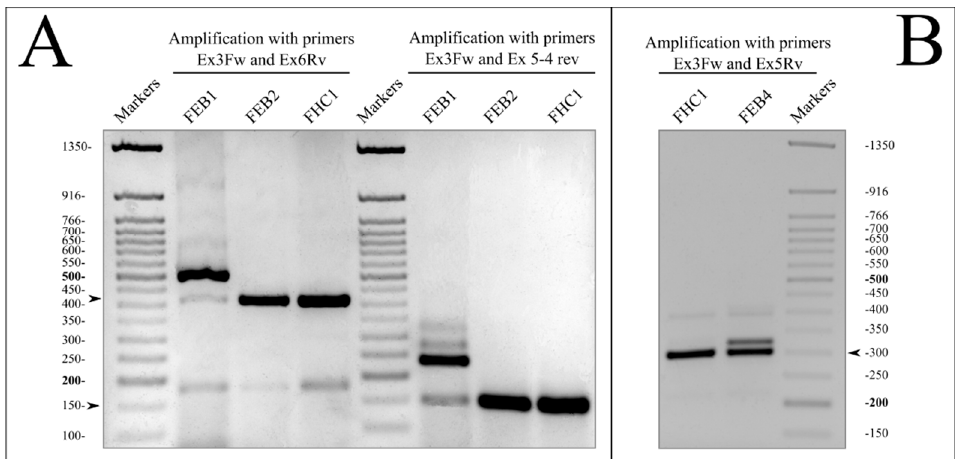
Figure 1. RT-PCR analysis of COL7A1. Markers-Fast DNA Ladder 50 bp (New England BioLabs, Ipswich, MA, USA). ( A ). COL7A1 splicing in the FEB1, FEB2 and FHC1 lines. PCR with two pairs of primers, corresponding to exon 3 and exon 6 (Ex3fw, Ex6Rv) and exon 3 and the exon 5-exon 4 junction (Ex3fw, Ex5-4rv), respectively. Normal splicing forms, indicated by arrows, represent the bands of 420 bp and 150 bp in lanes FEB2 and FHC1. For FEB1, the presence of the normal splicing form is clearly visible. The major splice form of FEB1 is the intron-retaining form with length of 505 bp. ( B ). COL7A1 splicing in FHC1 and FEB4. PCR with exon 3- and exon 5-specific primers (Ex3fw, Ex5Rv). Normal splicing forms (indicated by the arrows) represent the band of 300 bp; the aberrant splicing form represents the band of 320 bp in FEB4 lane. For uncut images, see Supplementary Figure S5.